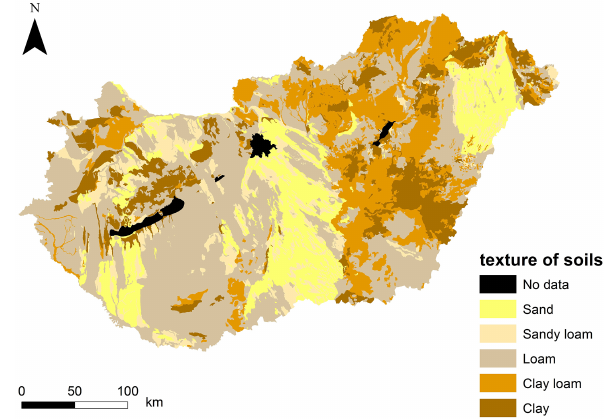
Figure 4. Adopted soil texture classes for Hungary based on an agrotopographical map (AGROTOPO, 1991). Table 2. Erodibility index of the soil texture classes; based on NAM